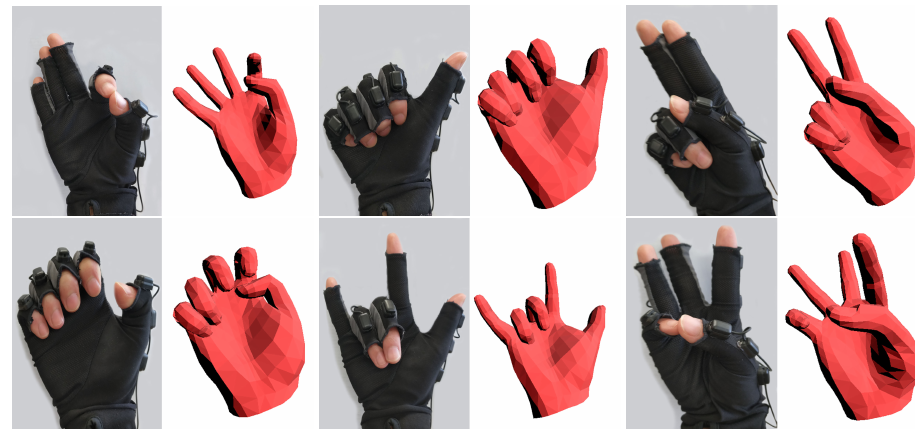
Figure 7. Some hand poses given by the simple data